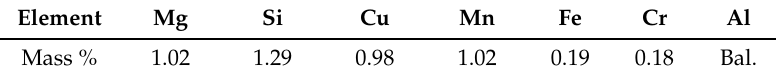
Table 1. Composition of 6066 Al alloy.